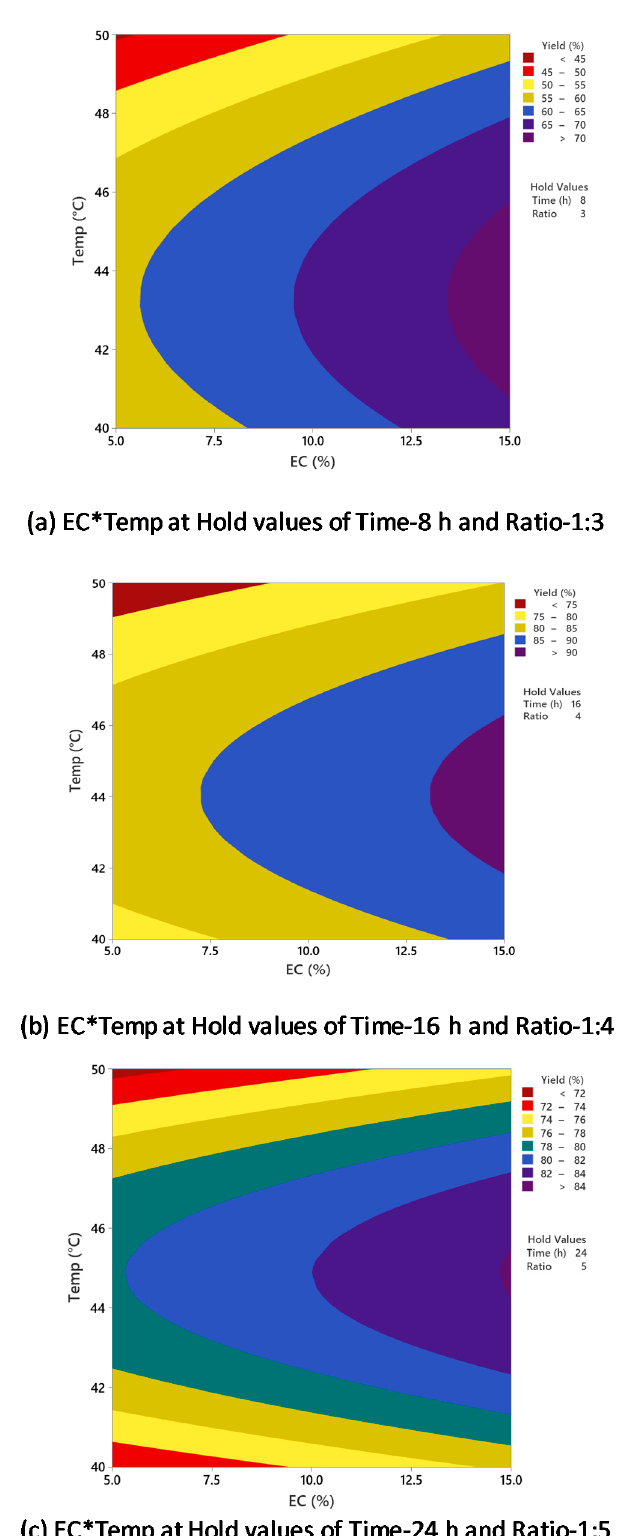
Figure 5. Counterplots of biodiesel yield vs. enzyme concentration and temperature at ( a ) 8 h and 1:3; ( b ) 16 h and 1:4; ( c ) 24 h and 1:5. 1:3; ( b ) 16 h and 1:4; ( c ) 24 h and